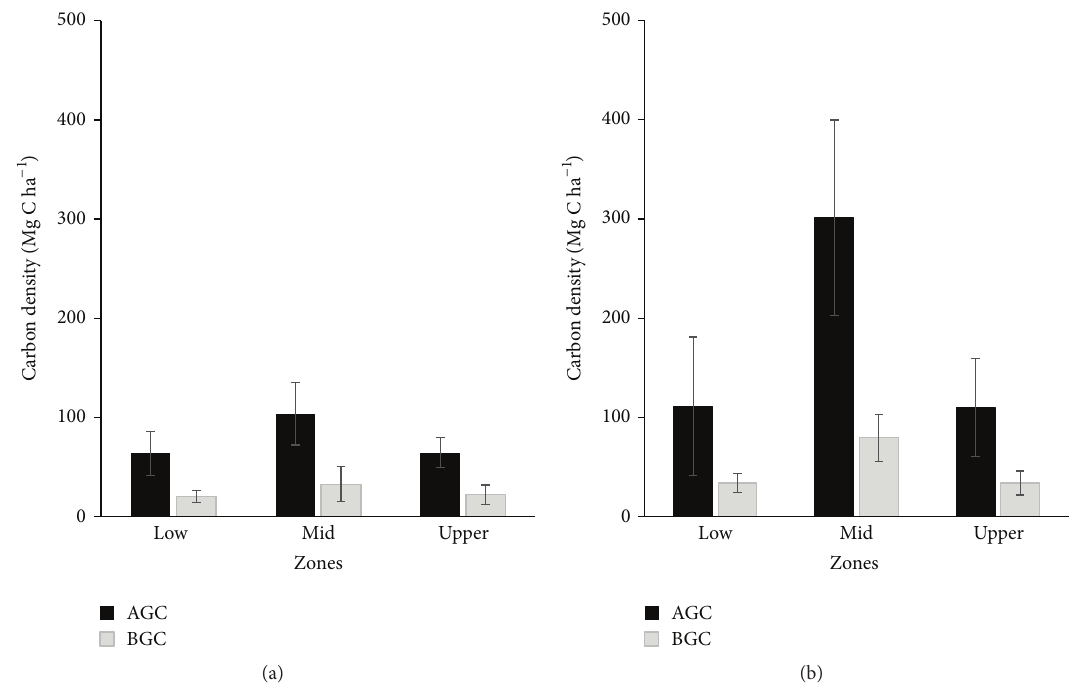
Figure 3: Mean AGC and BGC density (MgCha −1 ) in different zones for (a) Geza and (b) Mtimbwani (mean ± SD).